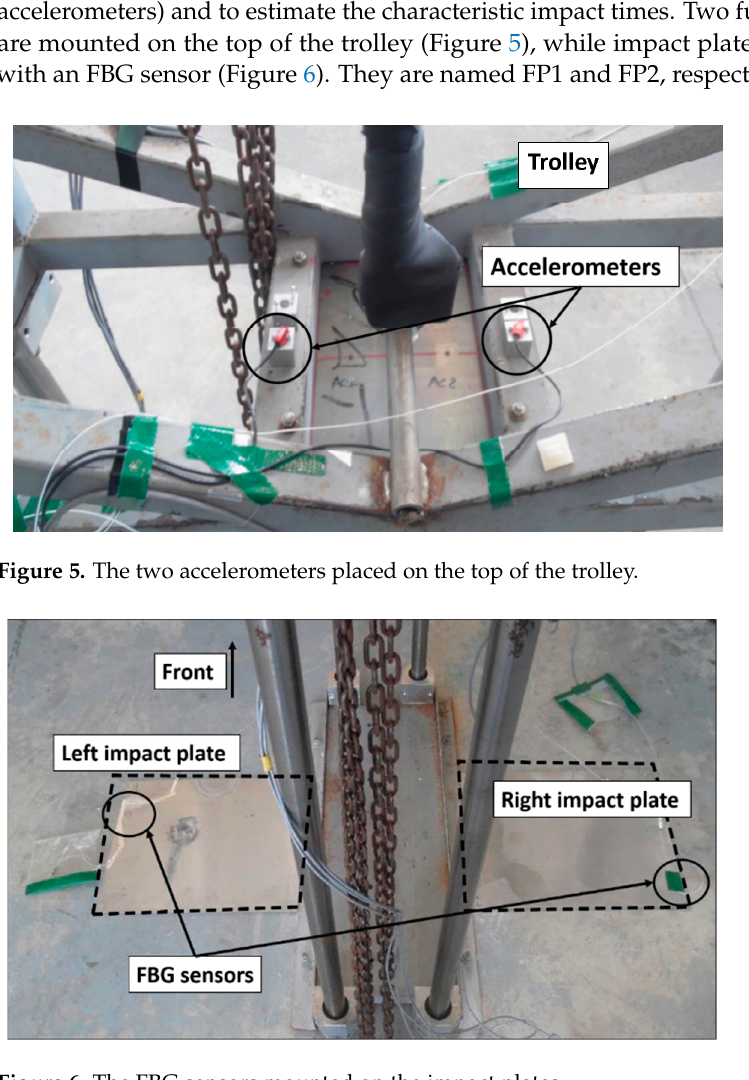
Figure 6. The FBG sensors mounted on the impact plates.